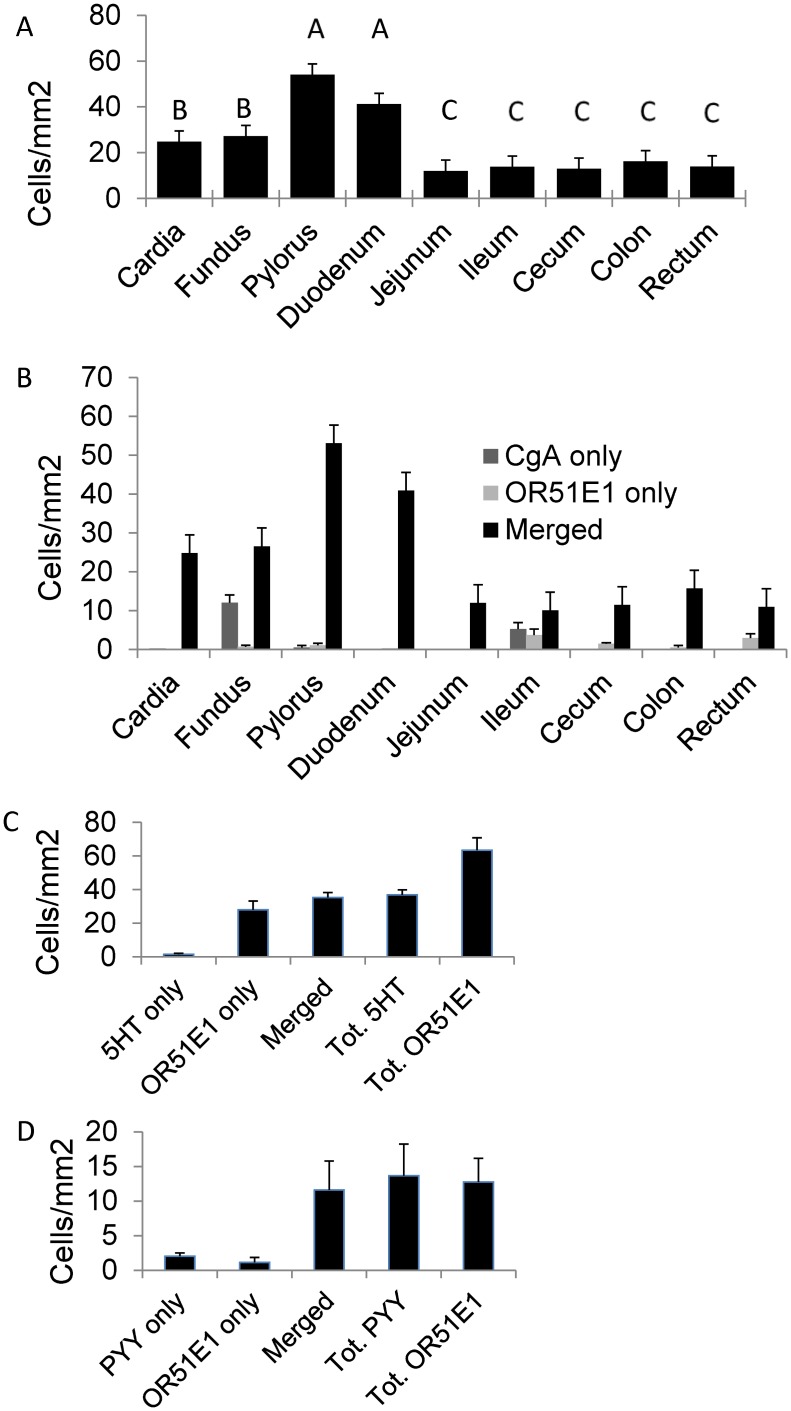
Immunostainings for OR51E1, chromogranin A (CgA), serotonin (5HT) and peptide YY (PYY) in different mucosae of the GIT.Counts (with standard errors of means) of: A) OR51E+ cells. PL = DU>CA = FU> JE = IL = CE = CO = RE (A,B,C: p<0.01); B) cells co-staining (= Merged) or not, for OR51E1 and CgA; C) cells co-staining (= Merged) or not, for OR51E1 and 5HT in jejunum; D) cells co-staining (= Merged) or not, for OR51E1 and PYY in colon.